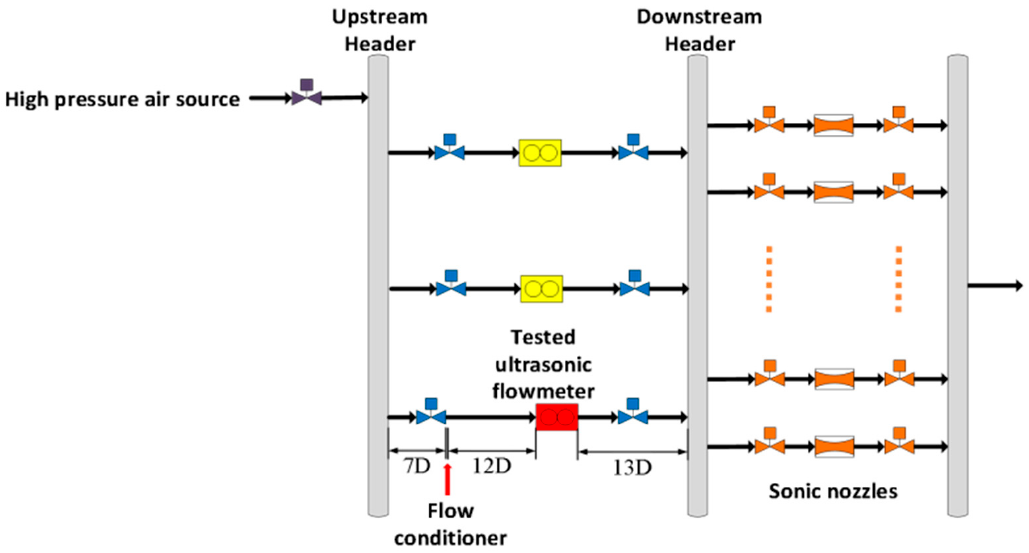
Figure 3. Schematic diagram of the sonic nozzle secondary standard device.